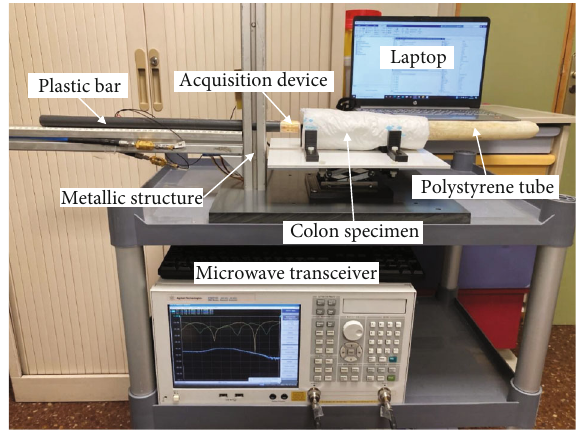
Figure 2: Measurement setup. The colon is wrapped around a polystyrene tube, and the acquisition device is attached to the tip of a plastic bar and connected to the microwave transceiver, the microcontroller, and the